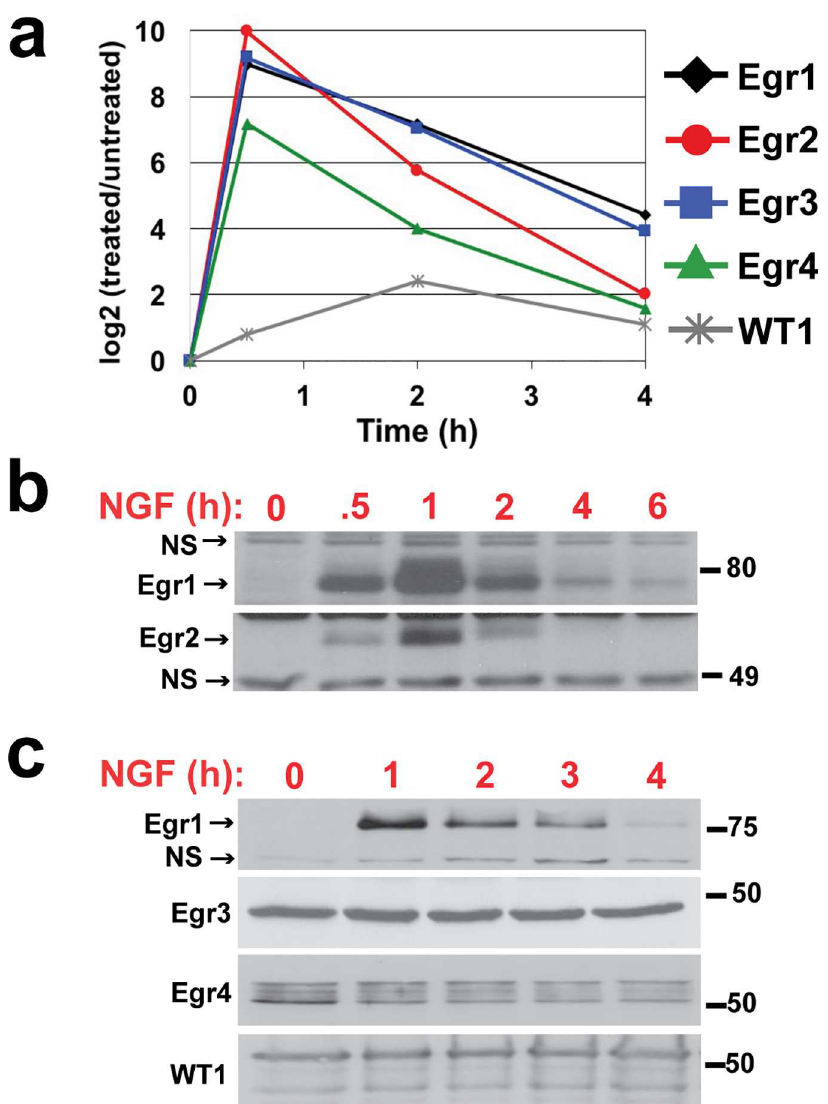
Fig 2. Time course analysisof Egr family expression following NGF treatment. PC12 cellcultureswere treatedwith 50 ng/mlNGF for 0–4 h beforeharvest. (a) Total RNA was extracted andsubjected to real-time RT-PCRto quantifychangesin mRNAlevelsor (b) total cell lysateswerepreparedandsubjectedto SDS-PAGE andWesternblot analysisto evaluatechangesin proteinlevels.NS, nonspecific band.